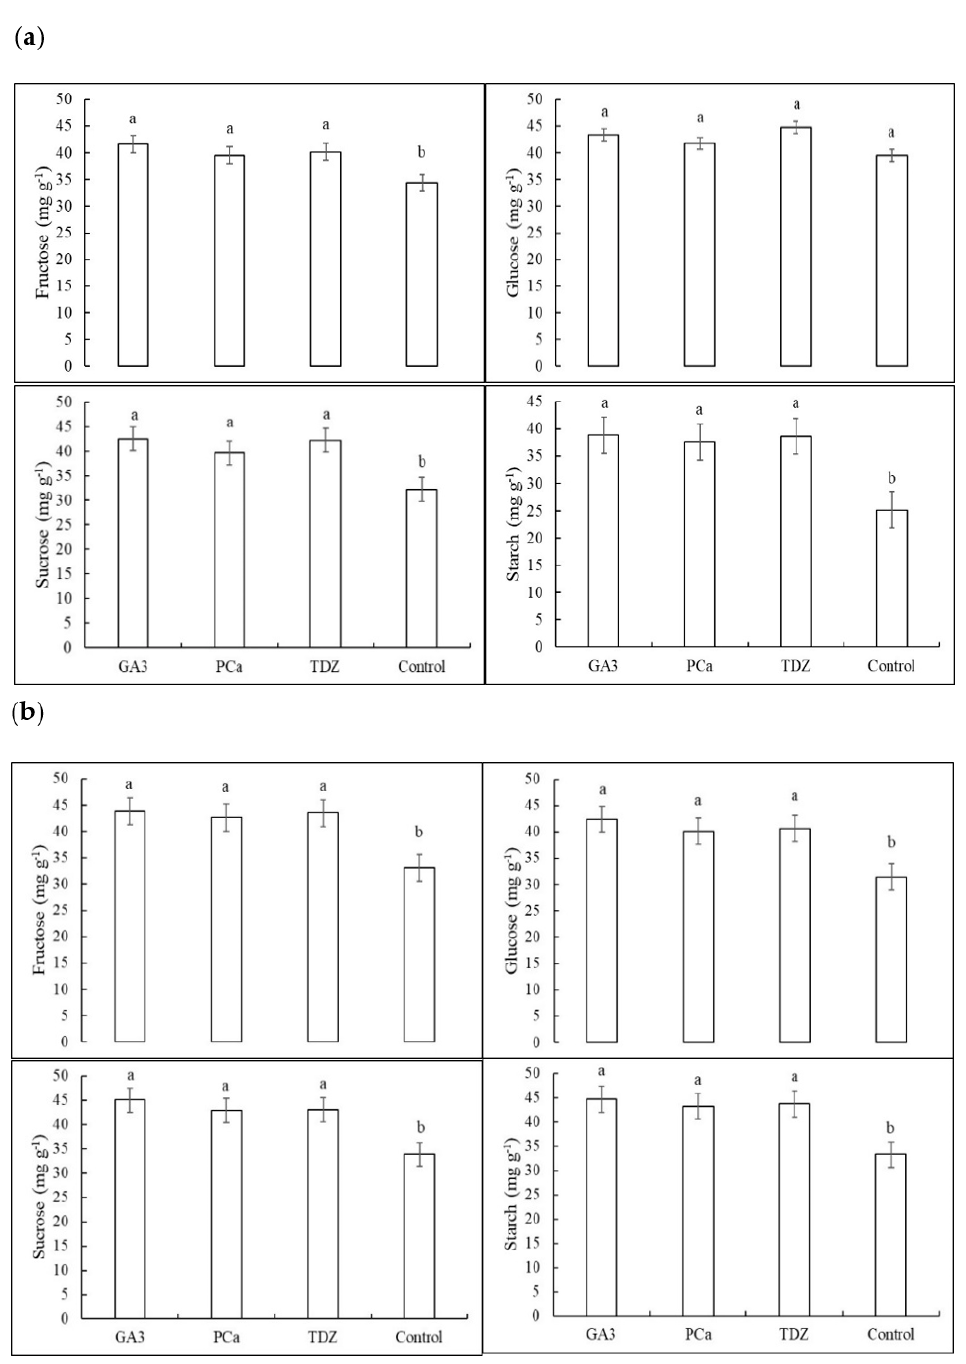
Figure 1. Concentrations of NSC in the leaflets ( a ) and buds ( b ) of pecan cv. Wichita treated with GR. The data are the means by treatment over two years (2017 and 2018). GA 3 : gibberellic acid (50 mg L − 1 ); PCa: prohexadione calcium (100 mg L − 1 ) and TDZ: thidiazuron (500 mg L − 1 ). Bars with the same letter are not different according to Tukey’s test ( p ≤ 0.05). Error bars represent standard deviations ( n = 5).